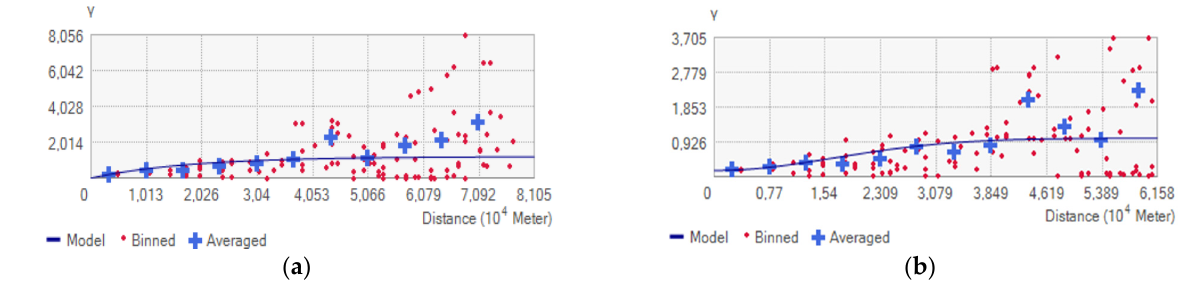
Figure 5. Semivariogram of the annual average precipitation: ( a ) 1964–1979; ( b ) 2005–2020. On the y-axis there is the semi-variance, while the x-axis shows the distance between pairs of observations. Analysing the average annual rainfall by interpolating the values of the two periods shows that there are some differences between the two periods, approximately 100 mm less rainfall for the period 2005–2020, 1153 mm for the period 1964–1979 and 1023 mm for the period 2005–2020 (Figure 6).